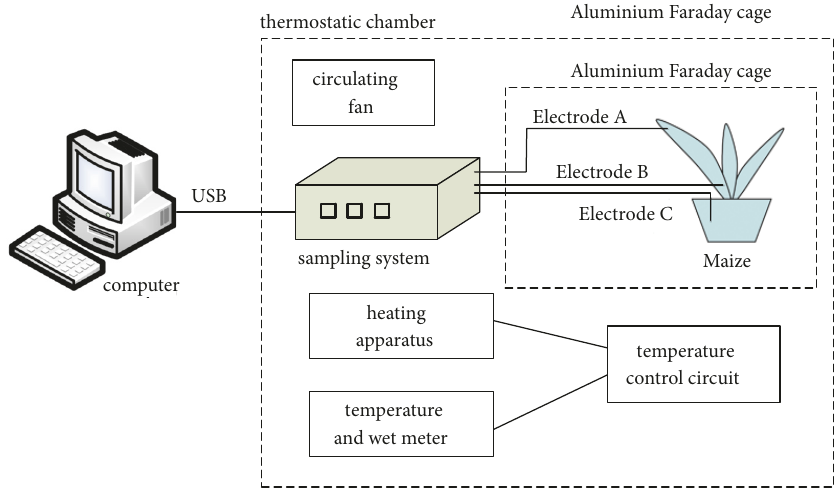
Figure 1: Schematic diagram of experimental